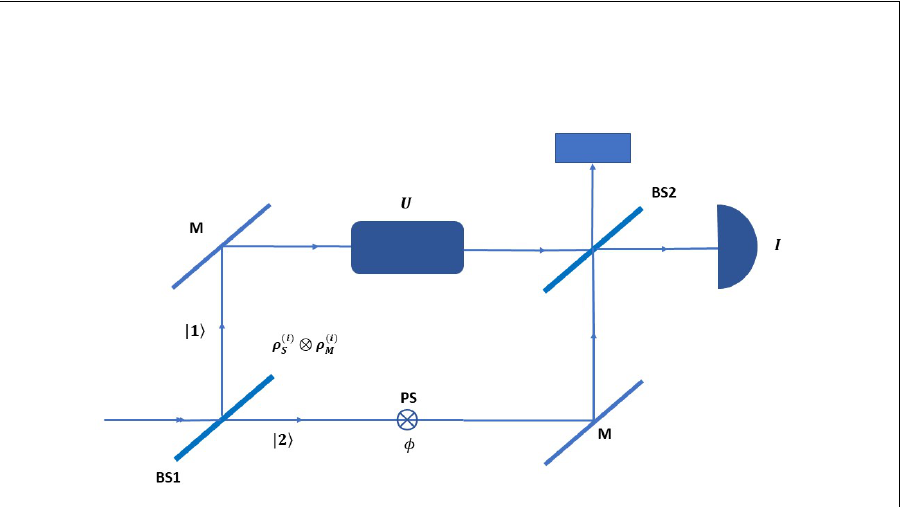
Figure 2. Mach–Zehnder-type setup to deal with two qubits. The path-qubit, associated to the two-way alternative, plays the role of the “system” or “quanton”. A quanton’s internal qubit (spin, polarization, etc.) serves as a which-way “marker”. The unitary U acts on the marker-qubit. BS1 and BS2 are beam splitters. An unbalanced BS1 can produce path states of the form | ψ (cid:105) = α | 1 (cid:105) + β | 2 (cid:105) . ( i ) ⊗ ρ ( i ) The initial, system-marker state ρ is available after BS1 and submitted to a non-local unitary M S (see text). By setting U to the identity one can address the single-qubit